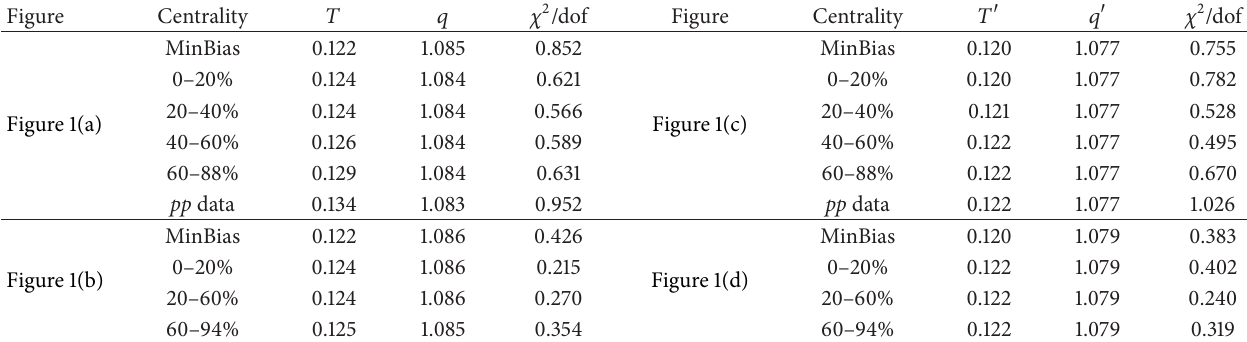
Table 1: Values of 𝑇 , 𝑞 , 𝑇 󸀠 , and 𝑞 󸀠 taken in Figure 1. 𝑇 and 𝑇 󸀠 units are GeV. Figure Figure